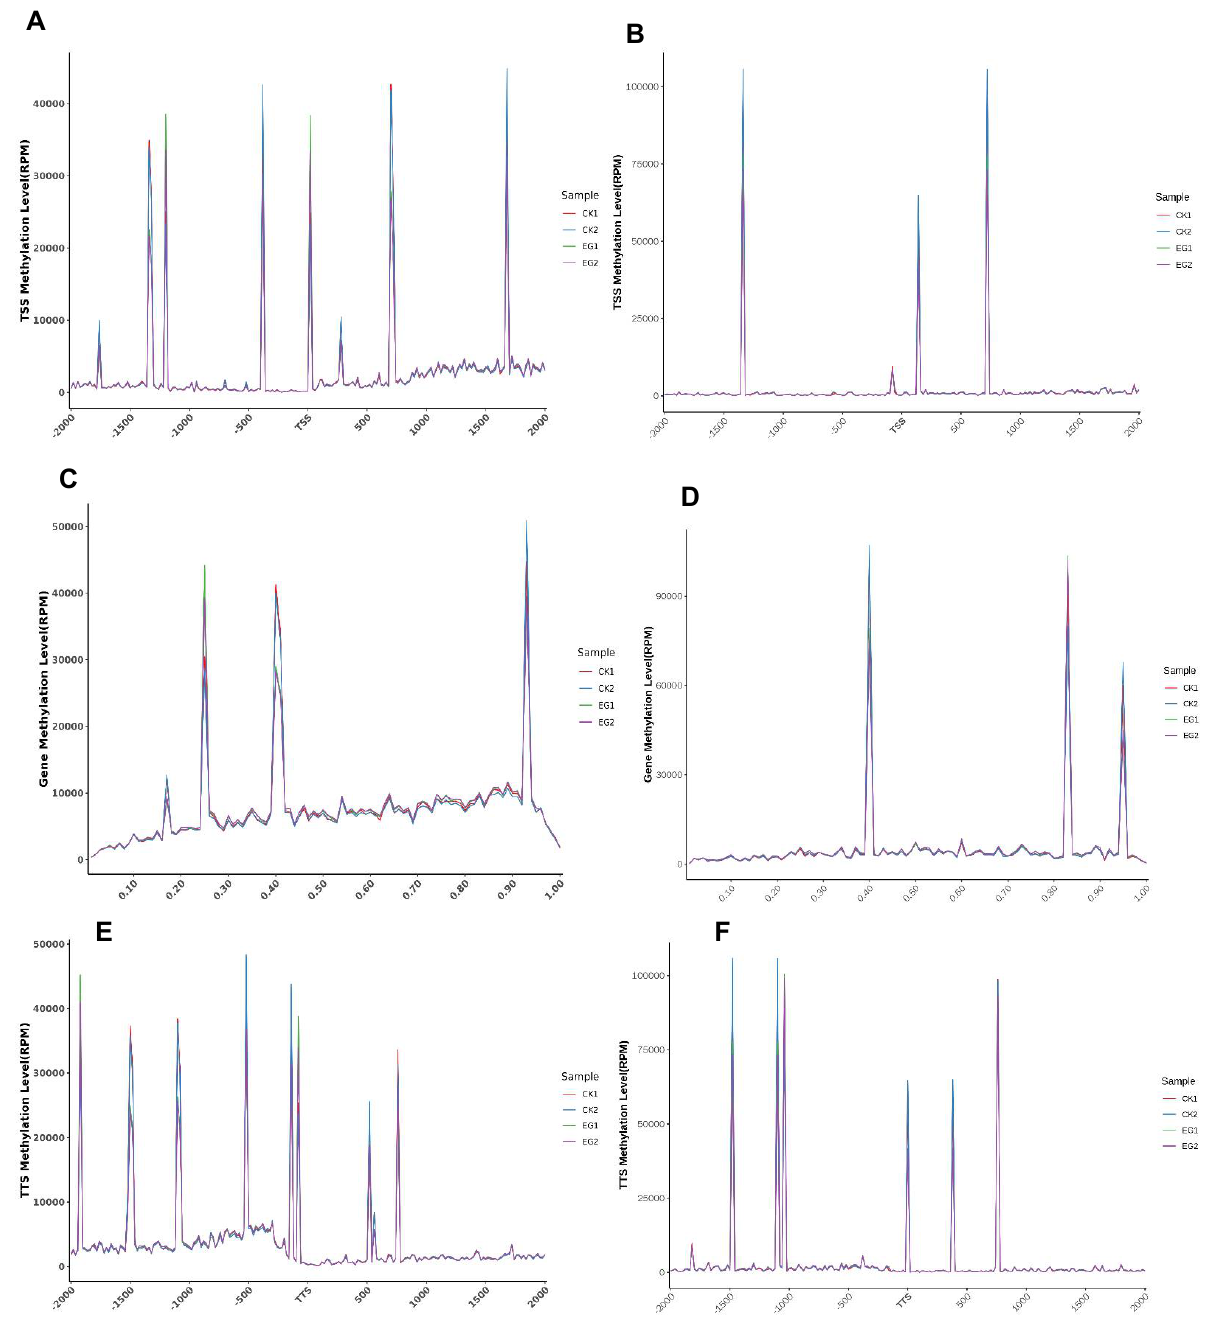
Figure 5. Distribution of methylation sites in transcription start site (TSS), gene body, and transcrip- tion termination site (TTS). ( A , B ) The distribution of CG and CWG methylation level in the TSS; ( C , D ) the distribution of CG and CWG methylation level in the gene body; ( E , F ) the distribution of CG and CWG methylation level in the TTS.